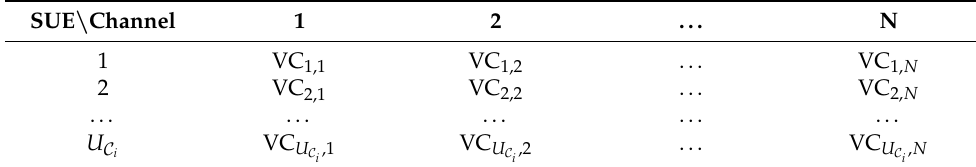
Table 2. The matrix of values of VC u , n . SUE \ Channel 1 2 ... N 1 VC 1,1 VC 1,2 ... VC 1, N 2 VC 2,1 VC 2,2 ... VC 2, N ... ... ... ... ... U C VC U VC U ... VC U C i ,2 C i , N C i ,1 i